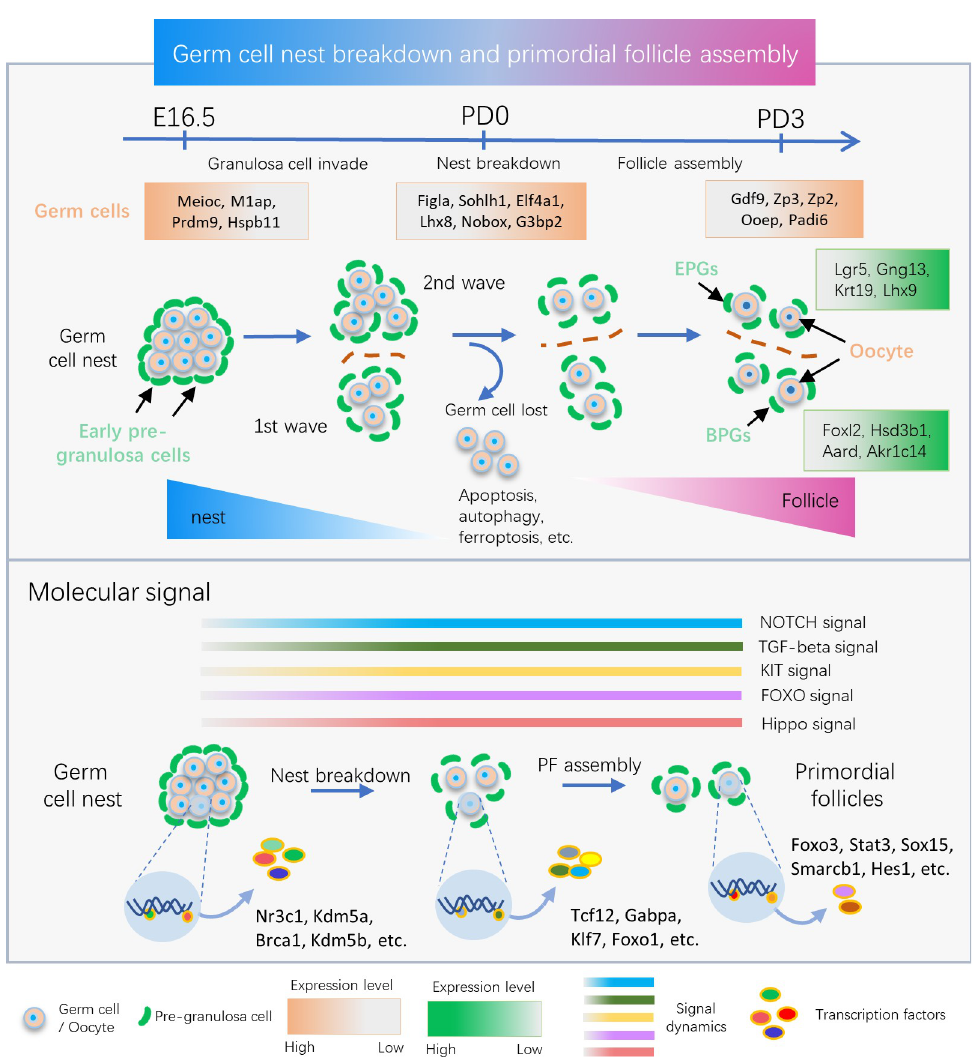
Fig 8. Schematic scheme of the main genetic and molecular signal dynamics detected in ovarian cells during follicle assembly. The upper panel indicates the genetic programs and key biological events of germ cells and pre-granulosa cells during germline nest breakdown and follicle assembly, and the developmental time courses are indicated above; the orange box contains the marker genes and their expression dynamics in germ cell; the green ones comprise the marker genes and their expression dynamics in pre-granulosa cell. The dark orange dashed line separates ovarian cortex (above) from the medulla, labeled with 2 sources of pre-granulosa cells, i.e., BPG cells for the first wave in ovarian medulla and EPG cells in ovarian cortex for the second wave of follicle formation, respectively. In the bottom panel (upper part), the activation of 5 main interactive pathways between germ cells and granulosa cells during these processes is represented. In the lower part, the stage-specific TFs in oocytes from nest to follicle stage are reported. BPG, bipotential pre-granulosa; EPG, epithelial pre-granulosa; TF, transcriptional